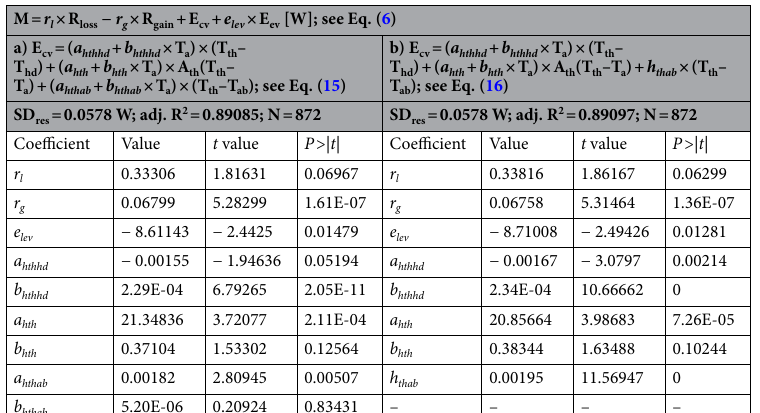
Table 3. Regression coefficients for mixed three compartment heat exchange models (comp. Stavenga et al. 45 ). ( a ) Model according to Eq. (15) in Eq. (6); ANOVA: F-value = 8638.83122, df = 863, P <<< 0.0001. ( b ) Simplified model according to Eq. (16) in Eq. (6); ANOVA: F-value = 9729.44757, df = 864, P <<< 0.0001. M = metabolic energy turnover, R loss = radiative heat loss, R gain = radiative heat gain, E cv = convective heat exchange, E ev = evaporative heat exchange (~ 0.004 W; 21,22 ); A hd , A th , A ab = surface area of head, thorax and abdomen, respectively; T hd , T th , T ab = surface temperature of head, thorax and abdomen, respectively; T a = ambient air temperature; SD res = SD of residuals; adj. R 2 = adjusted for df. P >| t | provides a measure of the statistic relevance of a coefficient.